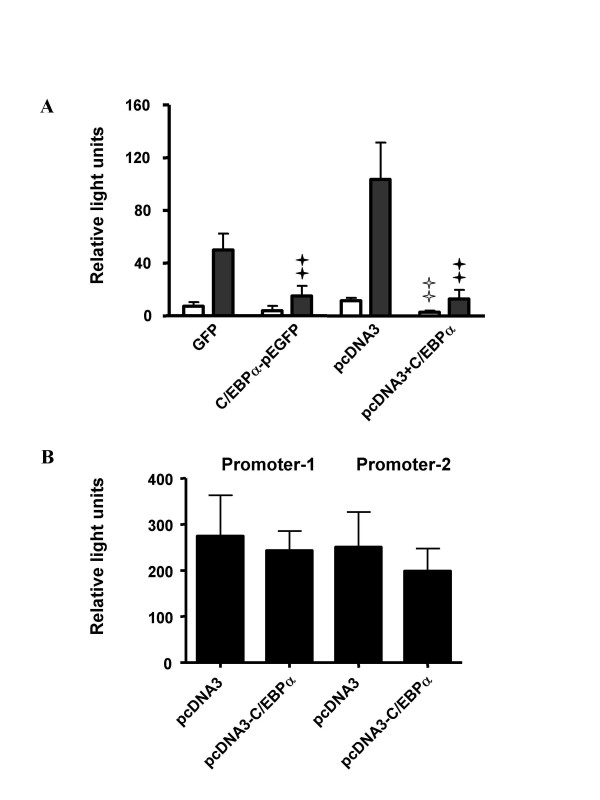
Inhibition of the activity of PSA promoter by C/EBPα. A. LNCaP cells were transiently co-transfected with a PSA promoter/enhancer-driven luciferase reporter plasmid and the C/EBPα expression plasmids, C/EBPα-pEGFP and pcDNA3-C/EBPα. After transfection, cells were treated for 36 hrs with 50 nM 5α-dihydrotestosterone (DHT) in RPMI 1640 medium supplemented with charcoal-stripped FCS. Cell extracts were collected with passive lysis solution, luciferase activity measured using pCMV renilla to standardize the transfection efficiency, and the results expressed as the mean relative light units ± standard deviation of 4 separate experiments. Open bars, basal transcription without DHT. Dark bars, transcription with DHT. Open double stars, statistically significant basal transcription in the C/EBPα expressing cells compared with control cells p-value < 0.01. Dark double stars, statistically significant DHT-stimulated transcription in the C/EBPα expressing cells compared with control cells with p-value < 0.01. B. Expression of C/EBPα did not inhibit the activity of PSMA promoter. The PMSA promoter-1(2 kb) and promoter-2 (5 kb) in the pGL-3 luciferase reporter plasmid, kind gifts from Dr. Sidney R. Grimes, were co-transfected with the C/EBPα expression plasmid into ALVA 101 cells. The luciferase assay was conducted as described in Methods.